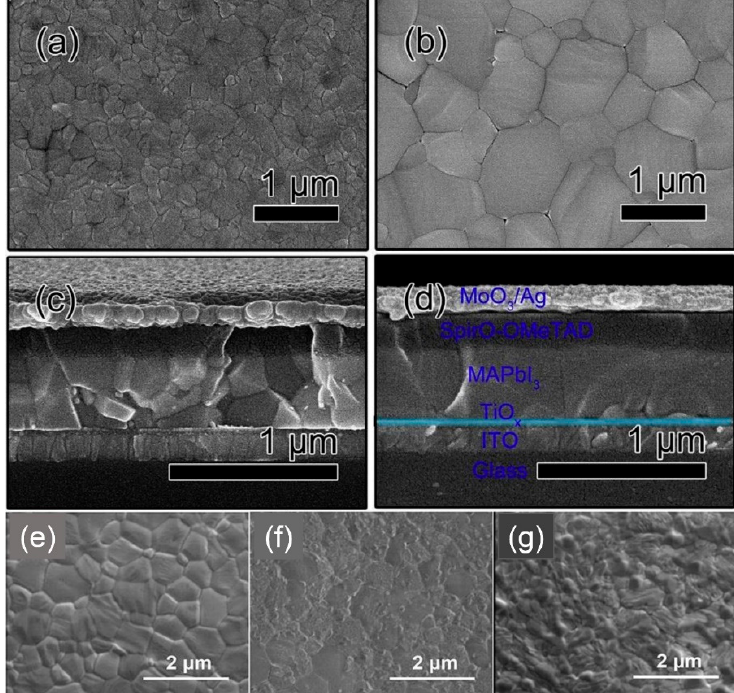
Figure 6. Effect of the precursor on the morphology change of the in-situ-grown 2D layer. Surface SEM images of ( a ) 3D perovskite and ( b ) a 3D/2D bilayered structure induced by diethylammonium bromide (DABr). Cross-sectional SEM images of devices employing ( c ) 3D perovskite and ( d ) a 3D/2D bilayered structure induced by DABr. Reprinted with permission from Ref. [30] Copyright 2019 Elsevier. Surface SEM images of ( e ) 3D perovskite film and a 3D/2D bilayered film caused by a post-solution treatment with ( f ) benzylamine (BA) and ( g ) BAI. Reprinted with permission from Ref. [36] Copyright 2018 American Chemical Society.